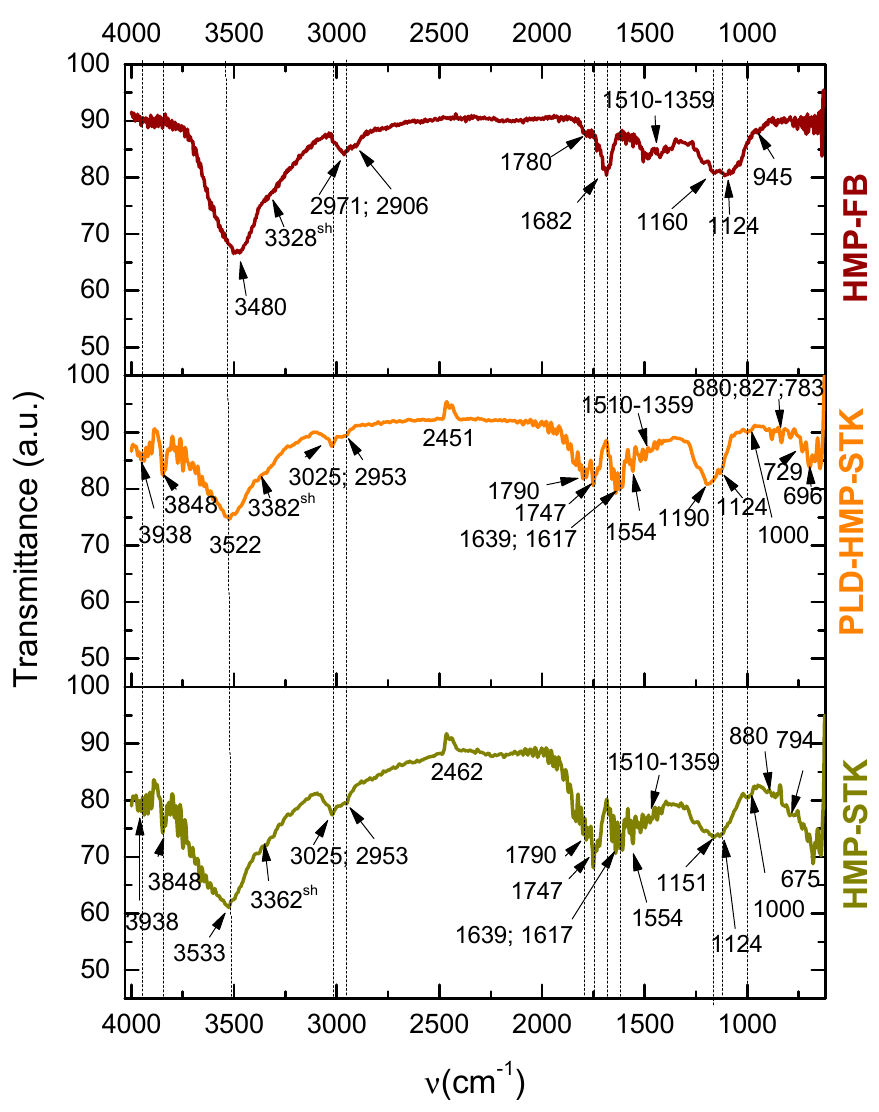
Figure 4. Fourier Transform Infrared Spectroscopy spectra: hemp stalk (HMP-STK); hemp fiber produced under the classical process for wet spinning (HMP-FB); thin film (PLD-HMP-STK) obtained under the PLD method applied to hemp stalk.